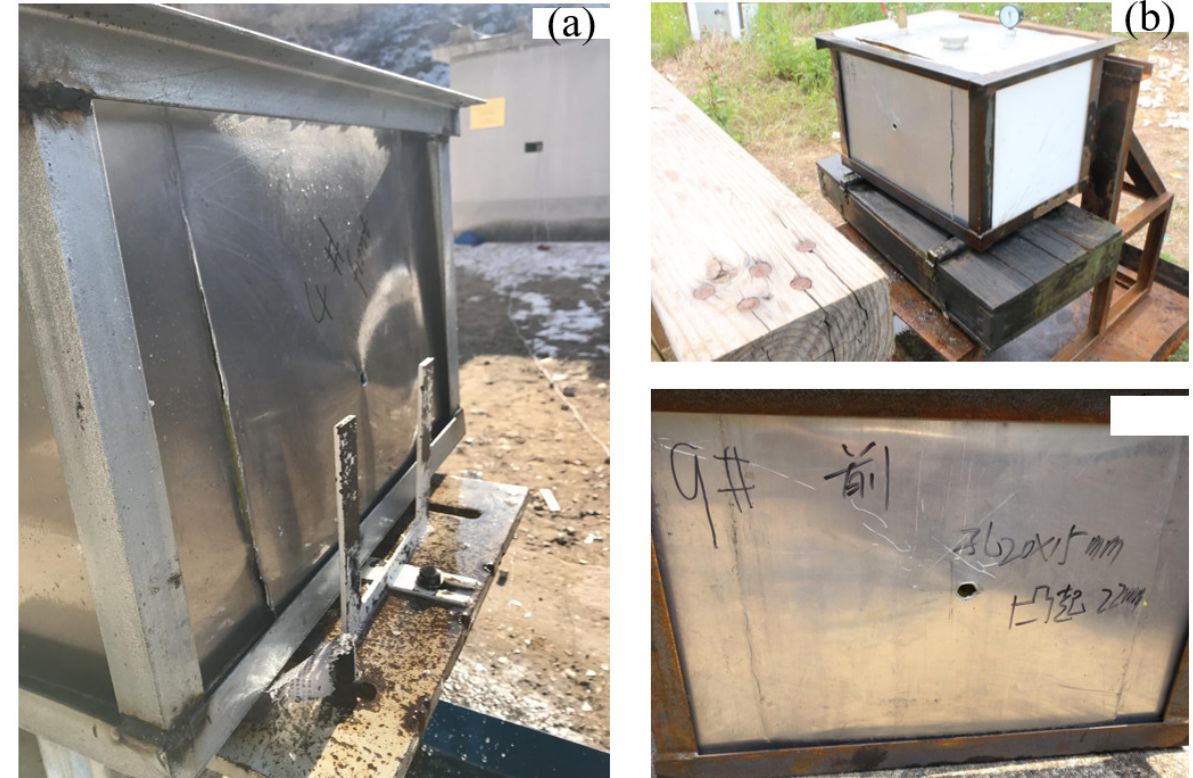
Figure 6. Damage to the fuel tank caused by steel fragments at medium and low speeds. ( a ) Damage to the fuel tank caused by the 10 g steel fragments at 1454 m/s; and ( b ) damage to the fuel tank caused by the 7 g steel fragments at 1868 m/s.